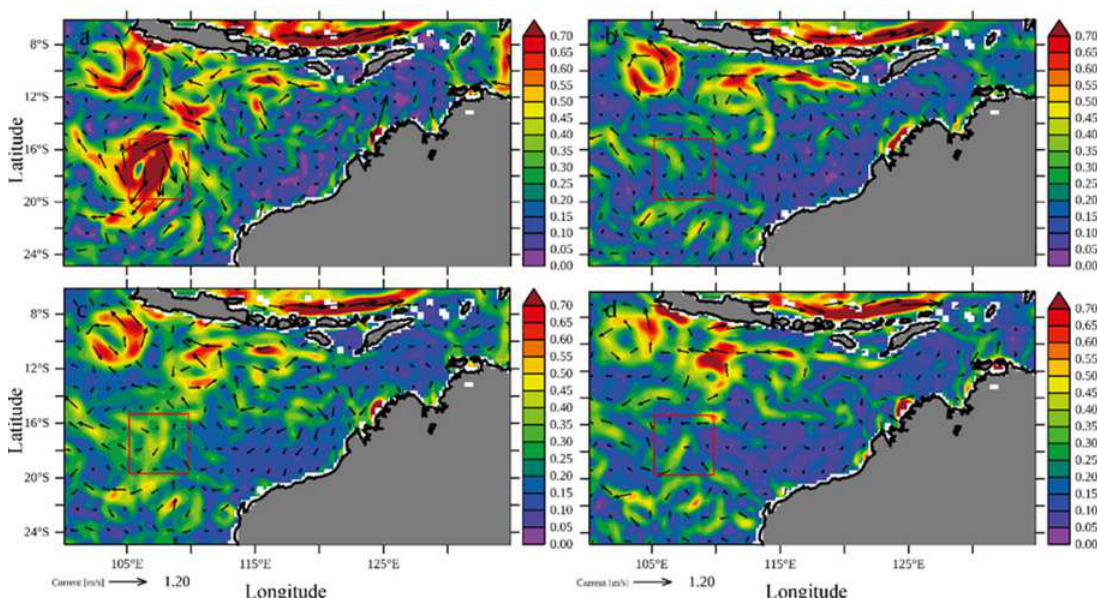
Fig. 3: The ocean flow pattern (color in m/s): (a) during the peak of Cyclone Marcus on 22 March 2018, (b) before Cyclone Marcus (March 11‐17), (c) during Cyclone Marcus (March 18‐25), (d) after Marcus (March 26‐31)